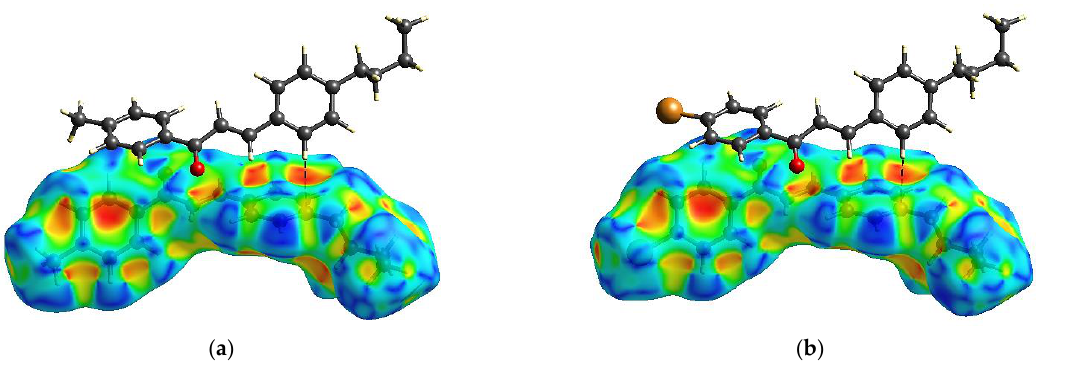
Figure 10. Shape index surface showing the C–H ··· π interactions establishing the crystal packing of ( a ) BMP and ( b ) BBP chalcones.